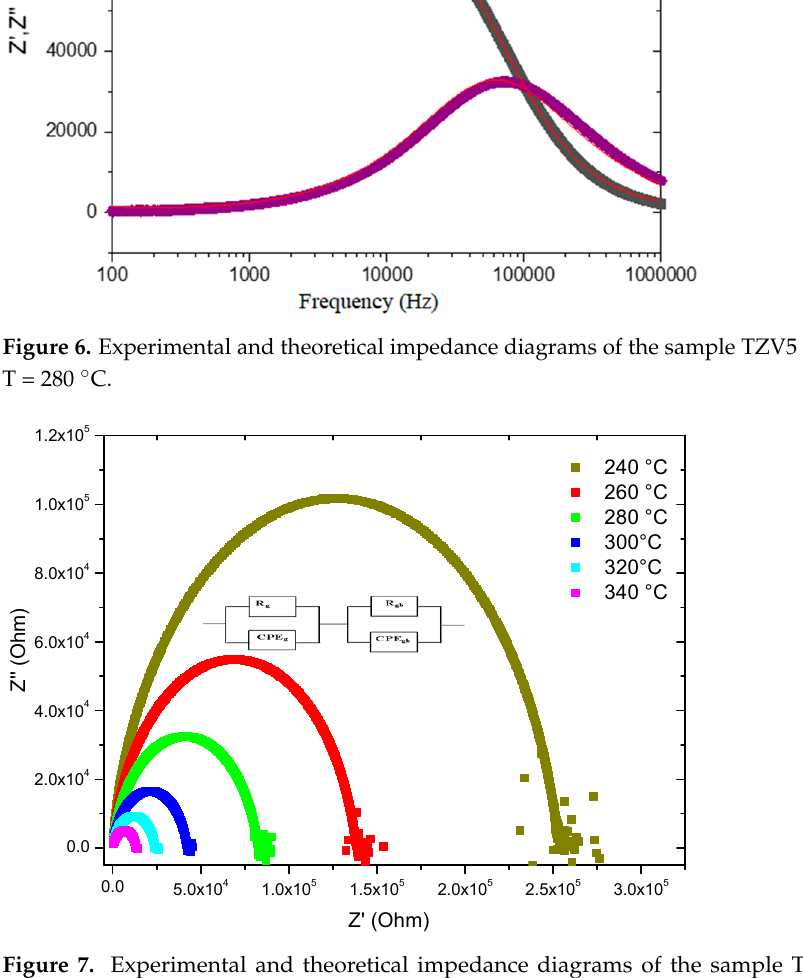
Figure 7. Experimental and theoretical impedance diagrams of the sample TZV5. Inset is the corresponding equivalent circuit at different temperatures.